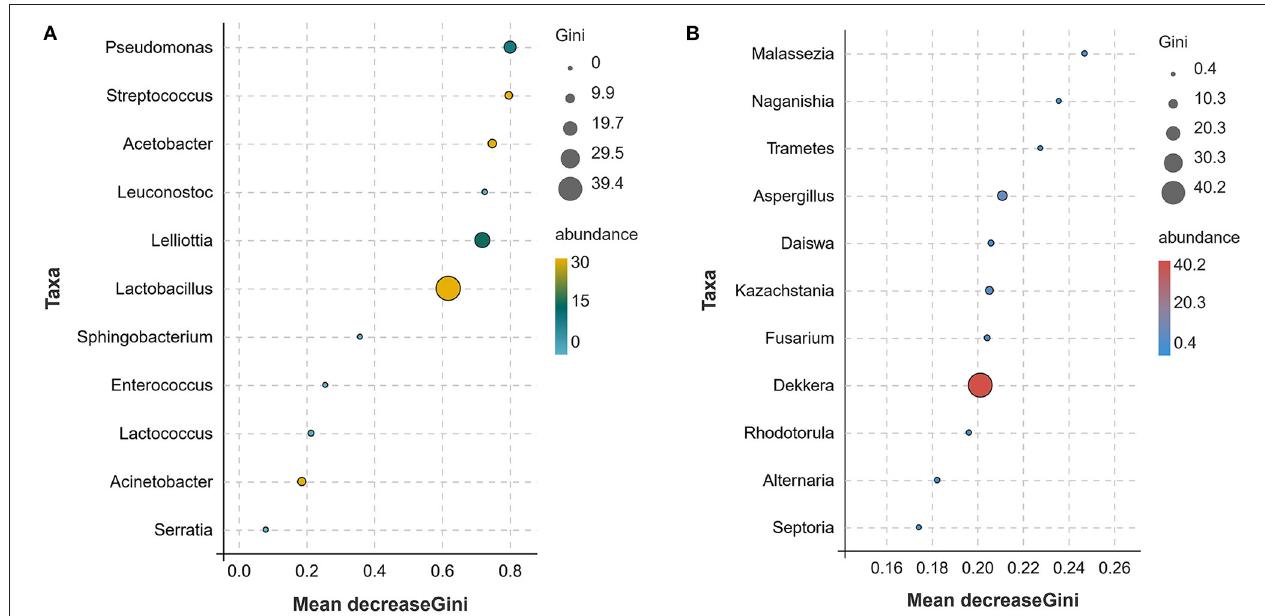
FIGURE 5 | Random forest analysis of bacteria and fungi [ (A) for bacteria, (B) for fungi]. The Gini index represents the purity of the nodes of the decision tree. The larger the Gini index, the lower the purity. The larger the species Gini index, the more obvious the effect of the species in distinguishing the two groups. Mean Decrease Accuracy is the mean square error, which is used to measure the degree to which the accuracy of the prediction results decreases when the variables are assigned randomly. The larger the value, the stronger the indicating effect of the species between the two groups. The size and color of the bubbles in the figure indicate the abundance of the corresponding species, and the position of the bubbles indicates the size of the index.